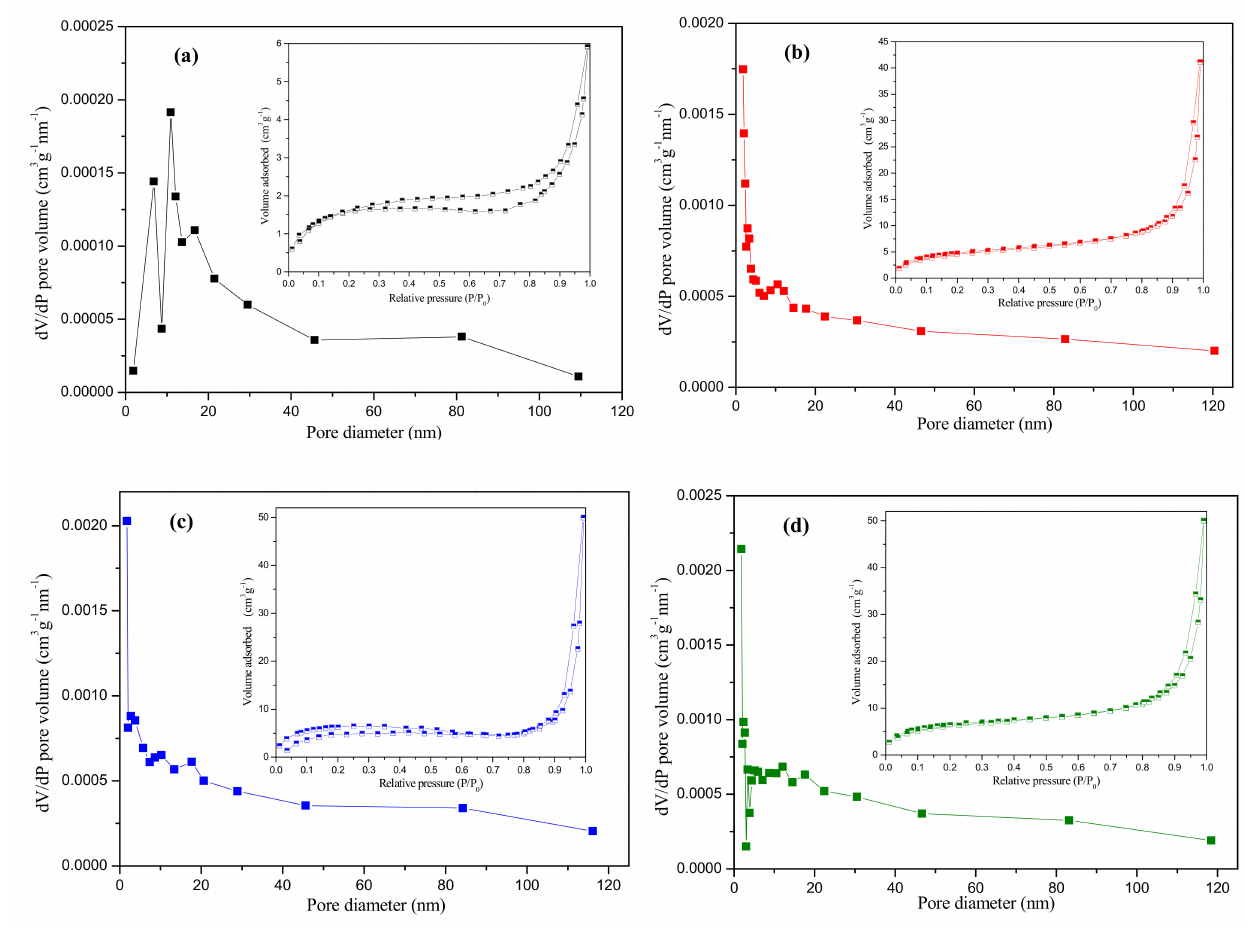
Figure 4. Pore diameter as a function of pore volume of ( a ) PVC, ( b ) MWCNTs-20, ( c ) MWCNTs-25, and ( d ) MWCNTs-28 membranes. The insets showed the nitrogen adsorption–desorption